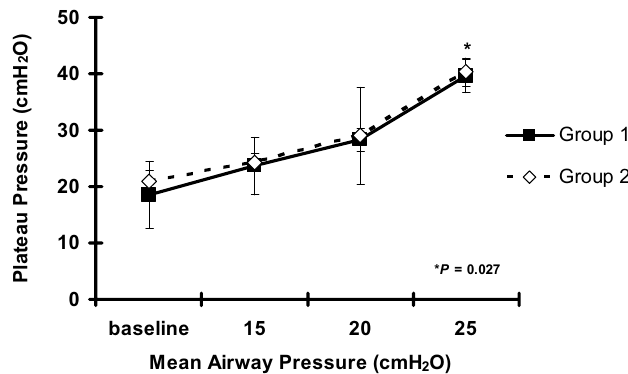
FIGURE 2 - Pulmonary Arterial Pressure: PAP significant higher when values of PAP between MAP 15cmH with the values of PAP in MAP 25cmH and P =0.031)